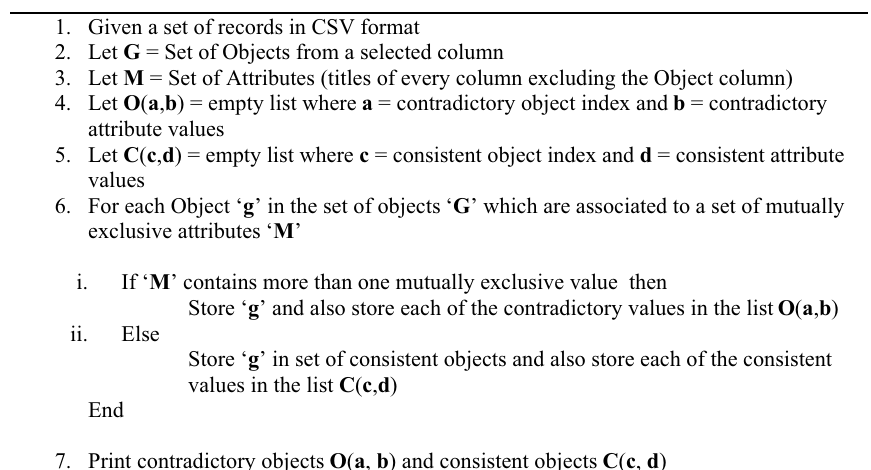
Algorithm 1: ConTra’s Algorithm for mining contradictory and